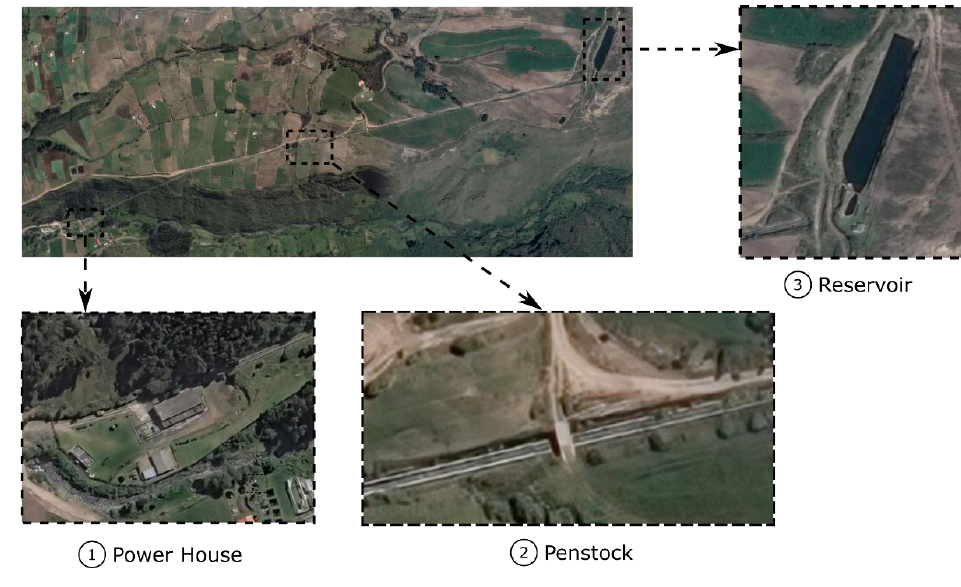
Figure 1. Hydroelectric Power Plant Illuchi N2. Table 1. Specifications of the generation